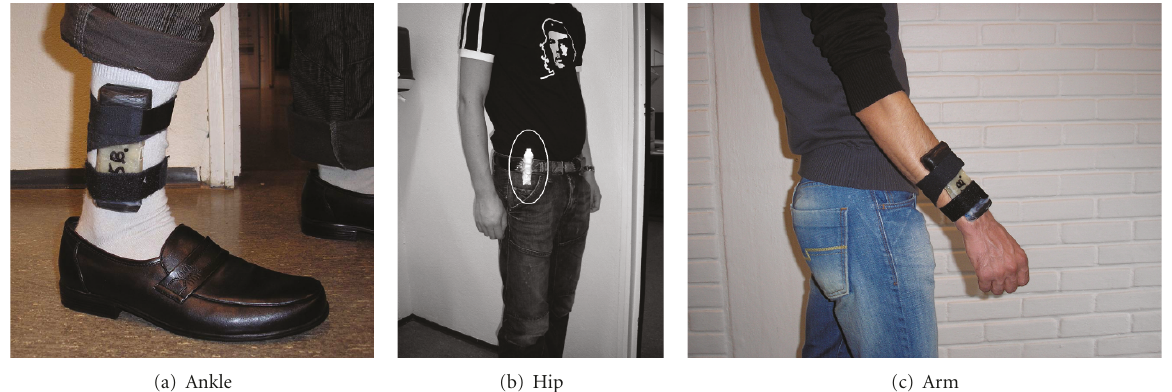
Figure 3: The placement of the MRS on the